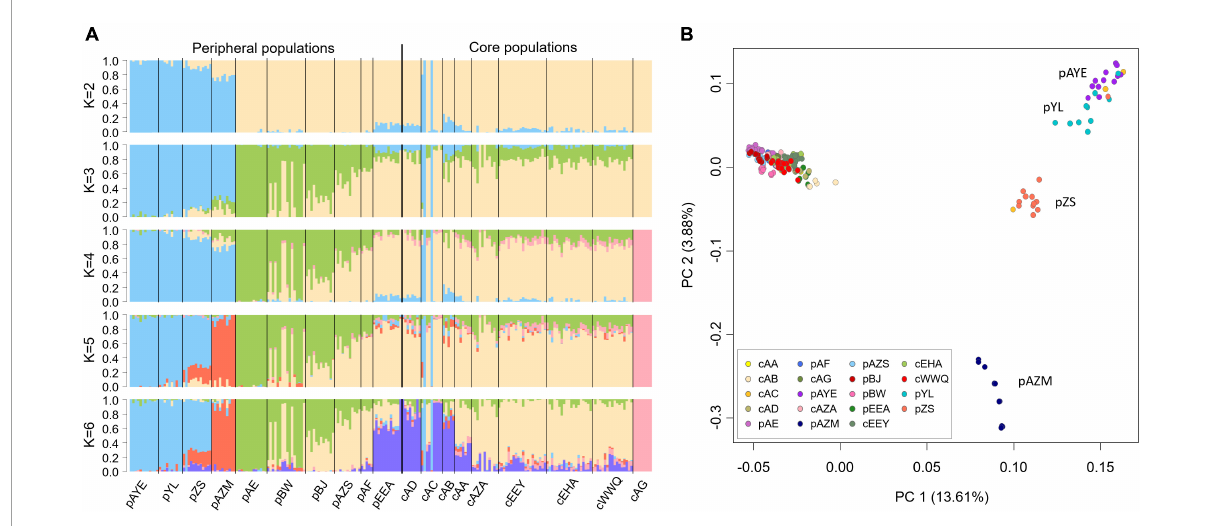
FIGURE4 Population genetic structure of Ammopiptanthus mongolicus inferred by (A) sNMF and (B) PCA with all SNPs. The optimal K of sNMF is 2, and K = 3–6 are shown to reveal detailed structure patterns.